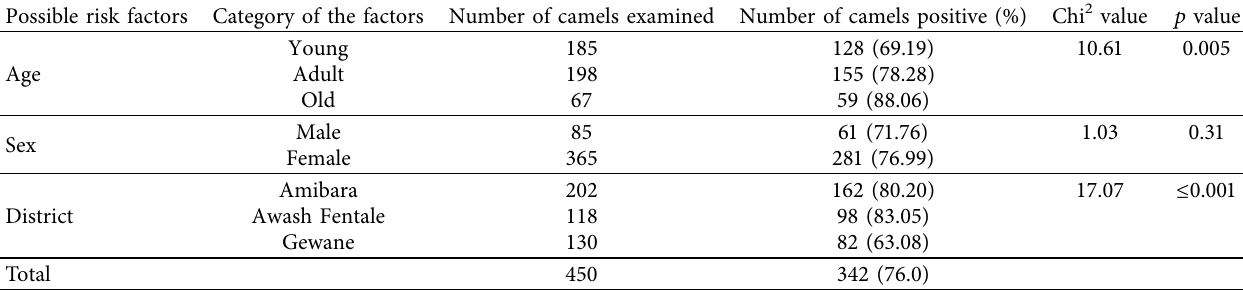
Table 3: Chi square analysis on prevalence of gastrointestinal parasites of camels based on the possible risk factors. Possible risk factors Category of the factors Number of camels examined Number of camels positive (%) Chi 2 value p value